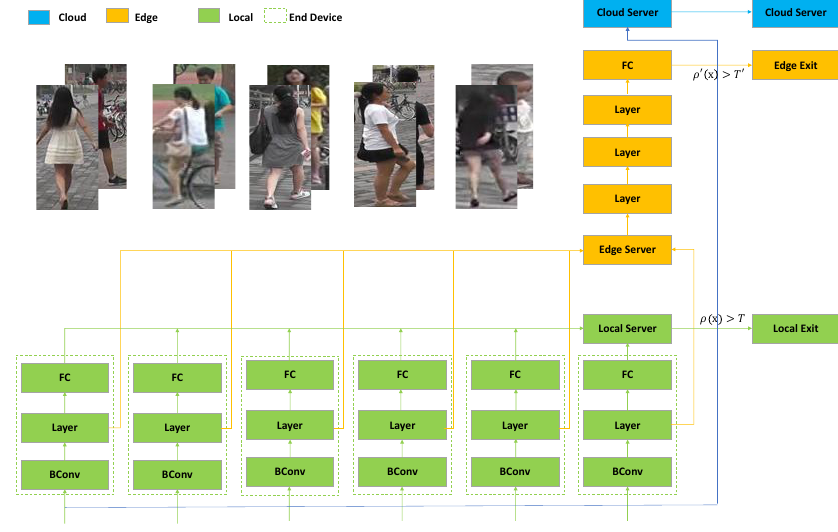
Figure 5. A segmented ResNet50 layer network framework for inference under the ReID scenario. And the images in this figure are from